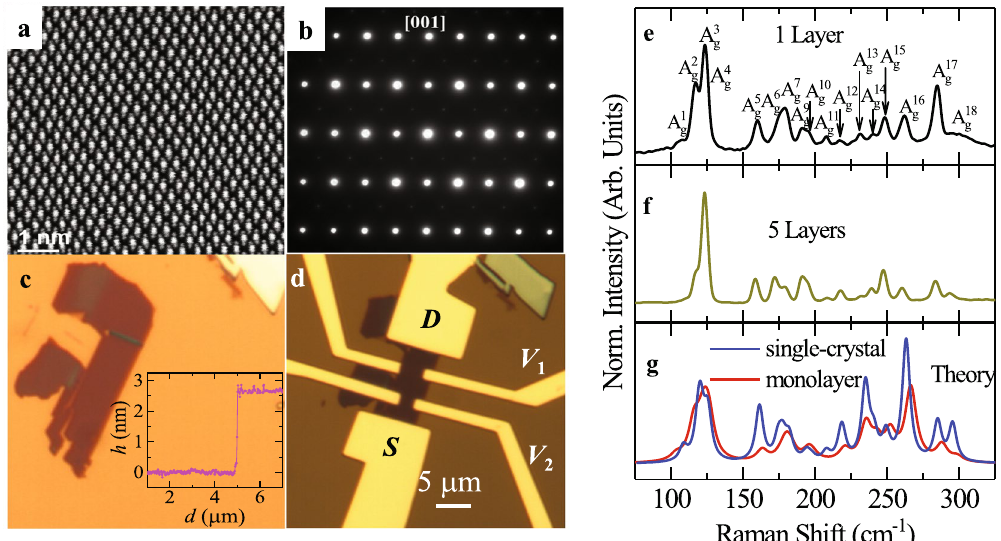
Figure 1. ( a) Scanning transmission electron microscopy (STEM) image of an exfoliated ReSe 2 single-crystal displaying a chain-like atomic arrangement. ( b ) Electron diffraction pattern for a ReSe 2 single-crystal when the incident electron-beam is perpendicular to the planar atomic arrangement showing a rectangular planar Brillouin zone. ( c ) Micrograph of a typical few layered ReSe 2 single-crystal exfoliated onto SiO 2 which from AFM (inset) had a step height of 2.7 nm, or was four layers thick (for an inter-planar lattice separation c = 0.6702 nm 5 ). ( d ) Micrograph of the same crystal after deposition of the electrical contacts which consisted of 50 nm of Au on a 5 nm layer of Cr. The larger electrical contacts were used to source (S) and drain (D) the current I ds when performing two-terminal measurements. The smaller contacts V 1 and V 2 were used for voltage sensing in four-terminal measurements. For this sample, the separation between the current leads was L ≅ 10.5 μ m, the width of the channel was w ≅ 3.6 μ m and the separation between voltage leads was l ≅ 4.5 μ m. ( e ) Raman spectra of a ReSe 2 monolayer. Given that inversion symmetry was the only symmetry operation present in the monolayer, in few-layers and in the bulk, there was just one Raman active irreducible representation, i.e. A g . Therefore, all peaks were associated with Raman A g modes. ( f ) Raman spectra for a crystal composed of five atomic layers. ( g ) Theoretical Raman spectra for monolayer (red) and bulk (blue) ReSe 2